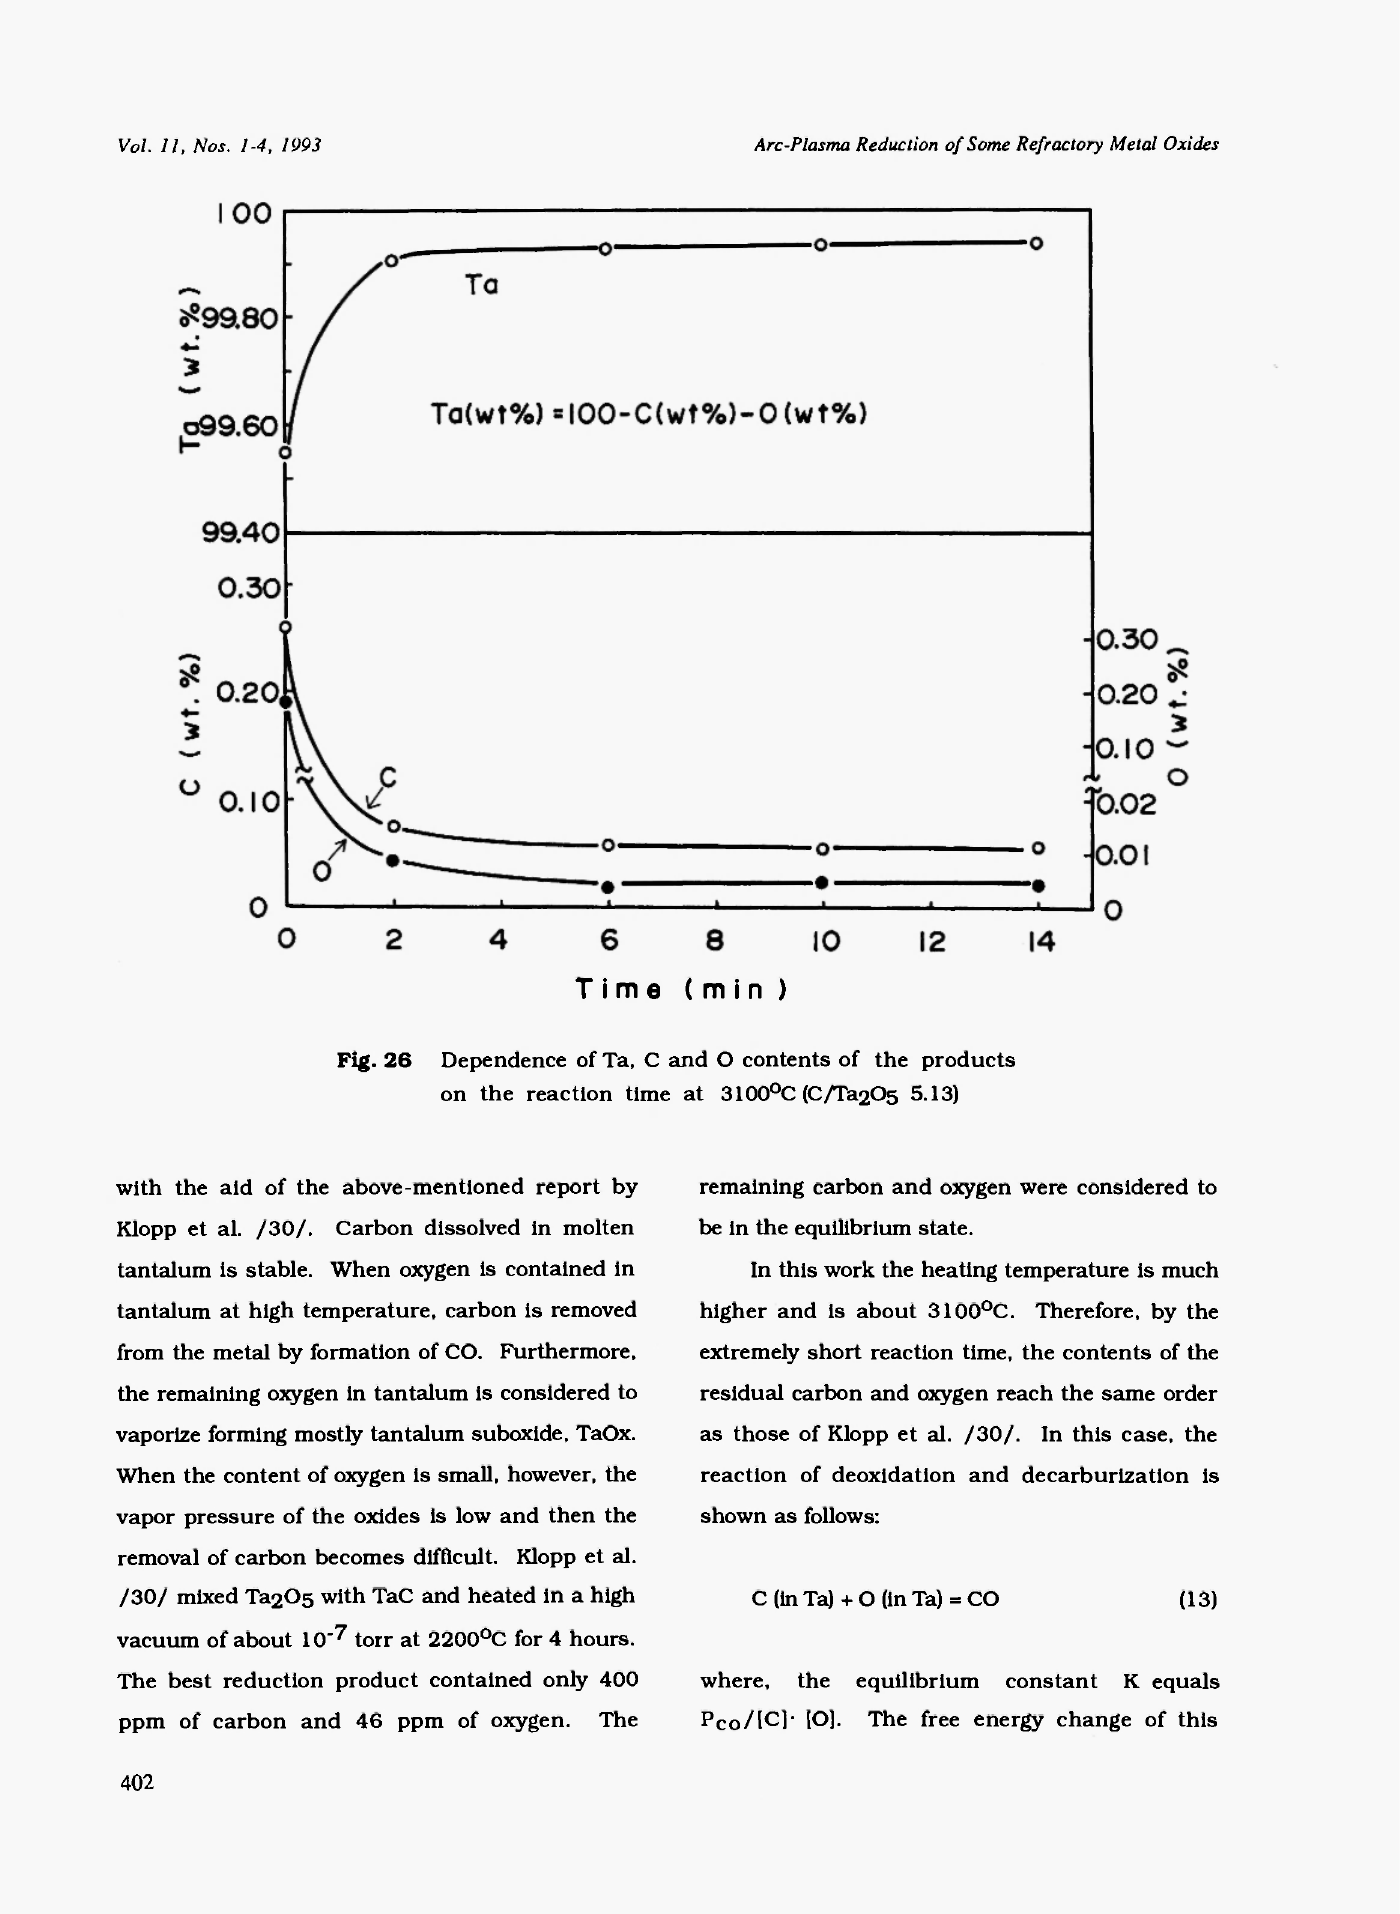
Fig. 26 Dependence of Ta, C and Ο contents of the products on the reaction time at 3100°C (C/Ta2C>5